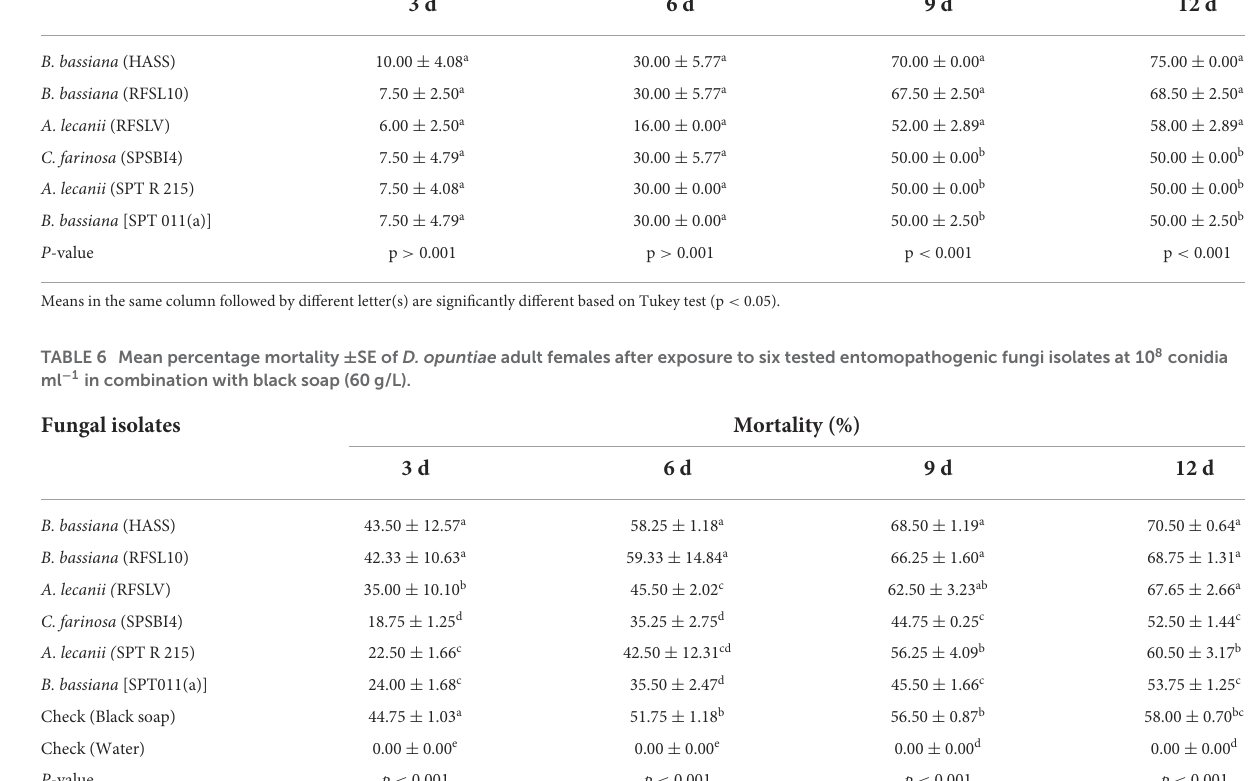
Fungal isolates